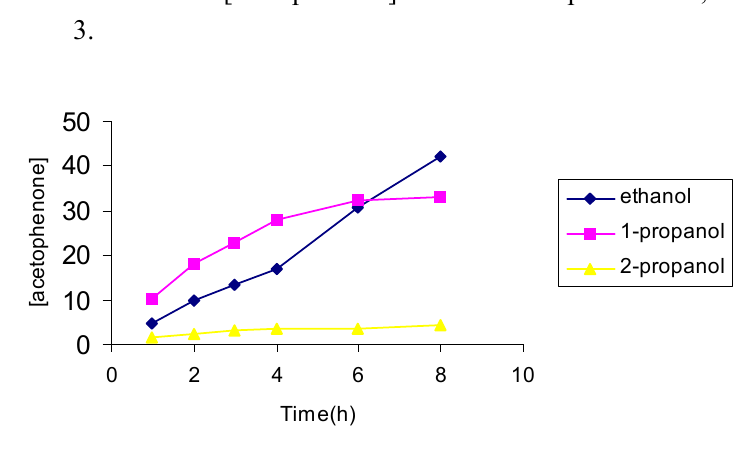
Figure 4. Variation of [acetophenone] vs. time for experiments 1, 2 and 3.